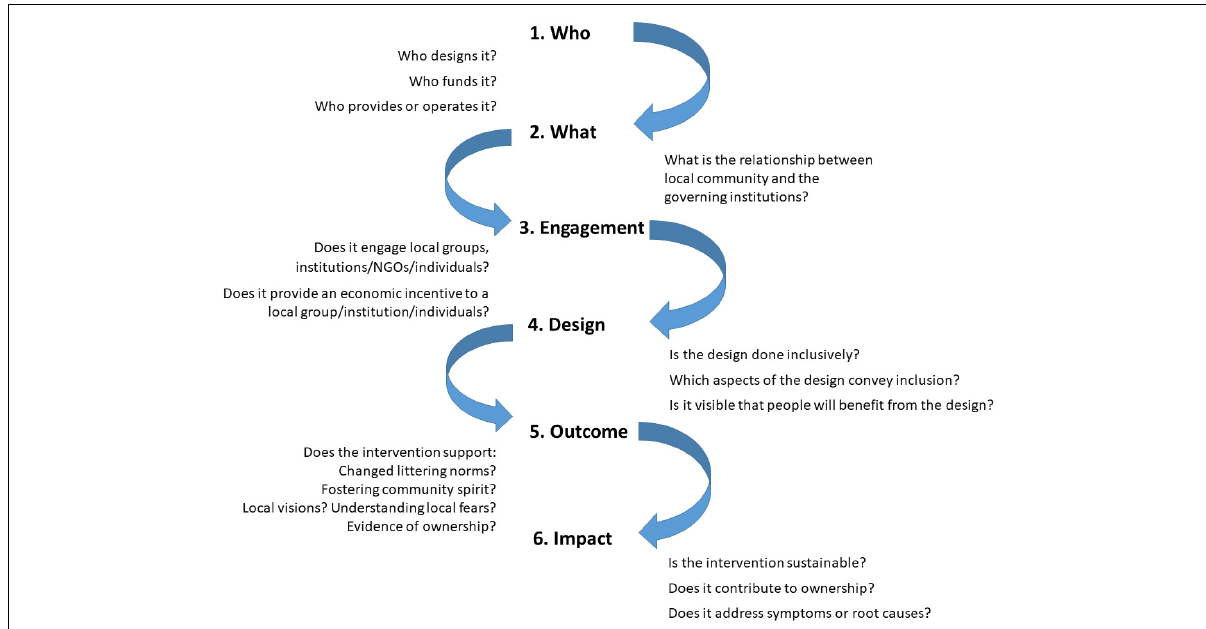
Figure 1: Brennan and Portman’s six-stage checklist designed to assess the potential effectiveness of litter interventions in a local